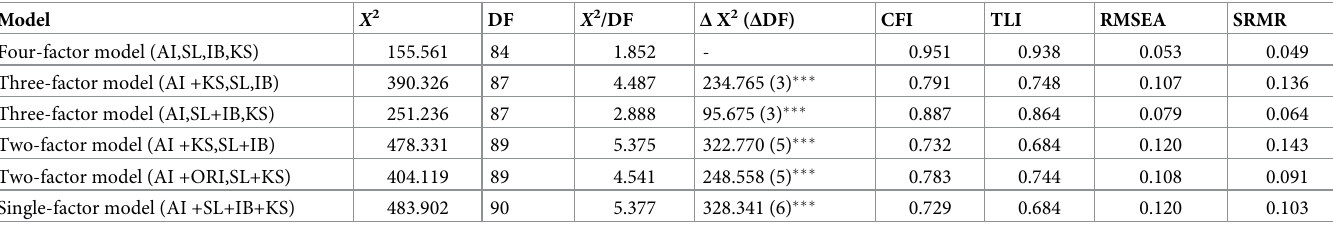
Table 4. Construct validity